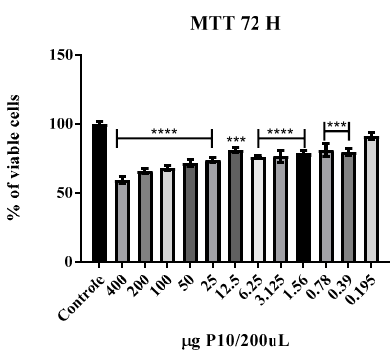
Figure 2. Cytotoxicity of P10-complexed chitosan nanoparticles in J774.16 macrophages with the aid of MTT colorimetric assay after 48 h and 72 h of co-incubation. At 48 h of incubation, only the concentration of 400 μ g P10/200 μ L showed toxicity to the cells ( p ≤ 0.01) compared to control using only DMEM medium. At 72 h, a cytotoxicity pattern was shown for almost all the concentrations tested. Data are represented as mean SEM and were analyzed by ANOVA statistical test with ** p ≤ 0.01, *** p ≤ 0.001 and **** p ≤ 0.0001 in comparison to the control group (DMEM).